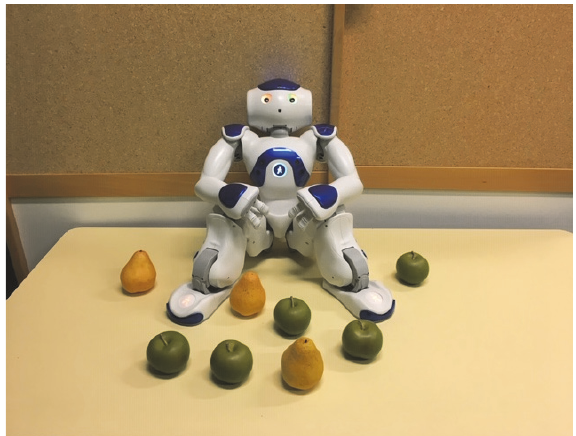
Figure 1: NAO and the fruits used in